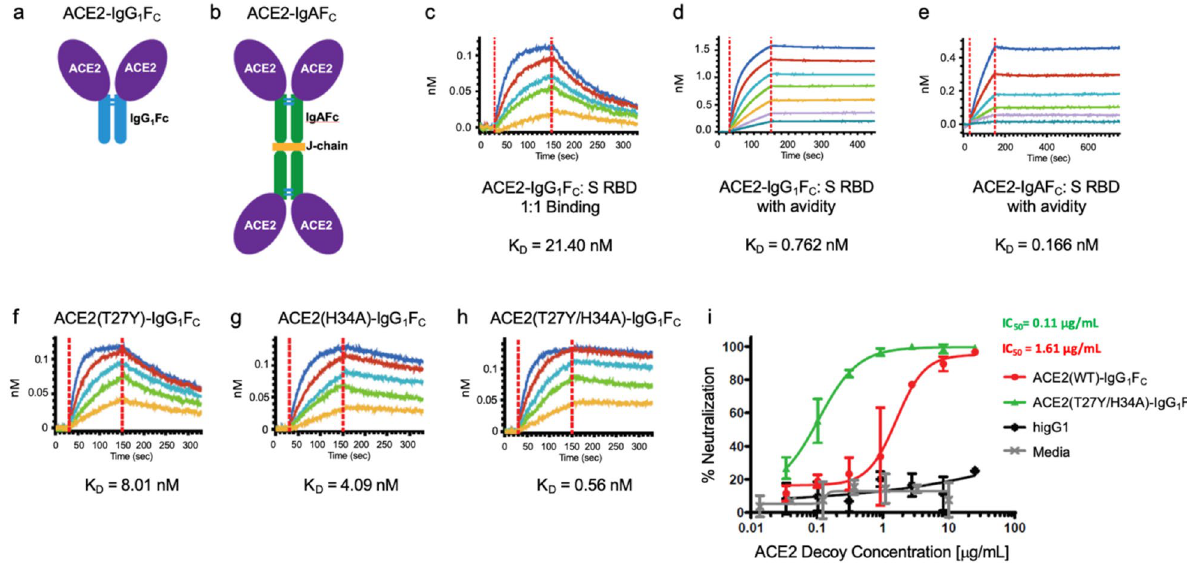
Figure 1. Biolayer Interferometry (BLI) of ACE2-IgG 1 F C , ACE2-IgAF C, and mutant decoy binding to the spike receptor binding domain; and live virus neutralization. The ( a ) ACE2-IgG 1 F C decoy and ( b ) dimeric ACE2-IgAF C decoy fused via a J-chain are shown. BLI kinetics analysis of ( c ) 1:1 binding and ( d ) binding with avidity for the ACE2-IgG 1 F C decoy; ( e ) BLI binding with avidity for the ACE2-IgAF C decoy; ( f ) ACE2(T27Y)- IgG 1 F C , ( g ) ACE2(H34A)-IgG 1 F C , and ( h ) ACE2(T27Y/H34A)-IgG 1 F C decoys are shown with K D values. ( i ) Virus neutralization as percent for concentrations of decoy is shown with IC50s for ACE2(WT)-IgG 1 F C and ACE2(T27Y/H34A)-IgG 1 F C . Negative controls: media and higG1 (human